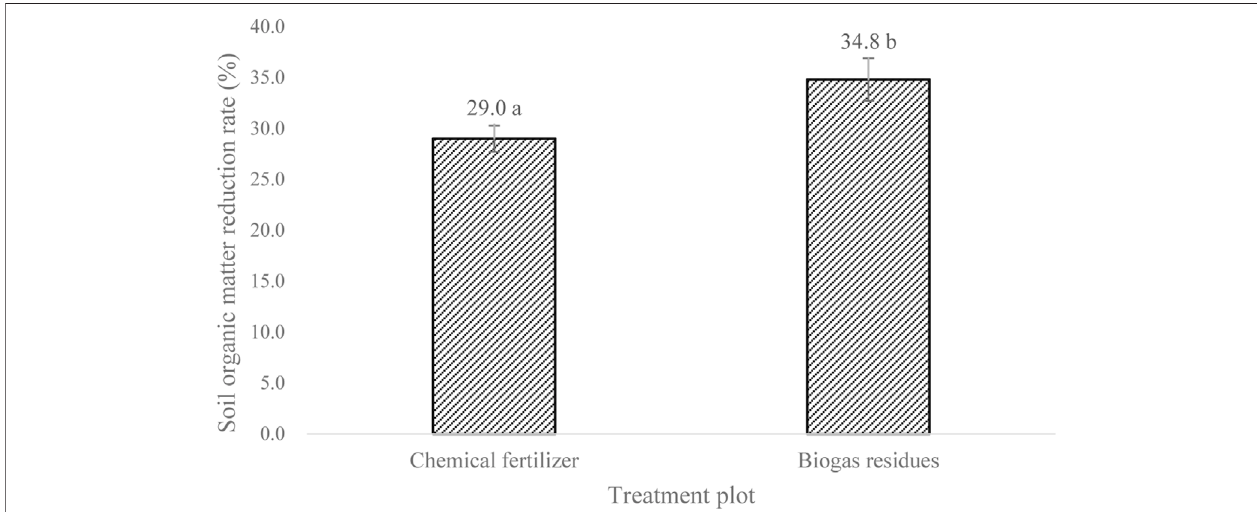
FIGURE 1 | Paddy soil organic matter reduction rate. Error bar is S.D. ( N = 3). Different lowercase letters denote signi fi cant differences ( p < 0.05), analyzed by ANOVA followed by Duncan multiple comparison